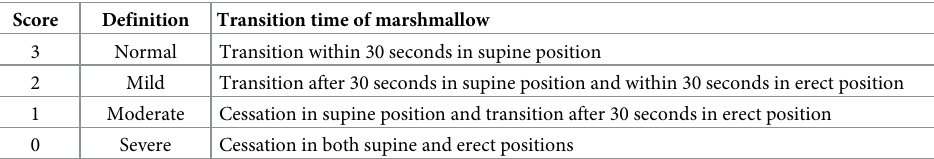
Table 1. Classification of marshmallow